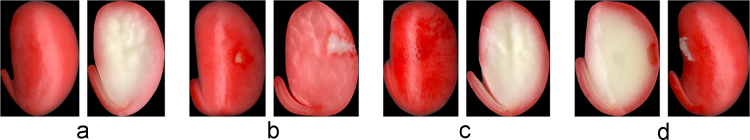
Examples of external and internal portions of seed samples. (a) without damage (perfect). (b) with bug damage. (c) with humidity damage. (d) with mechanical damage.